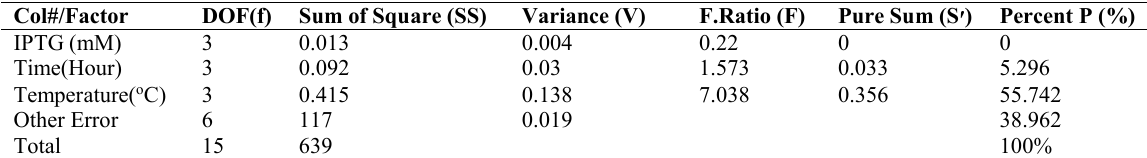
Table 2. ANOVA analysis.